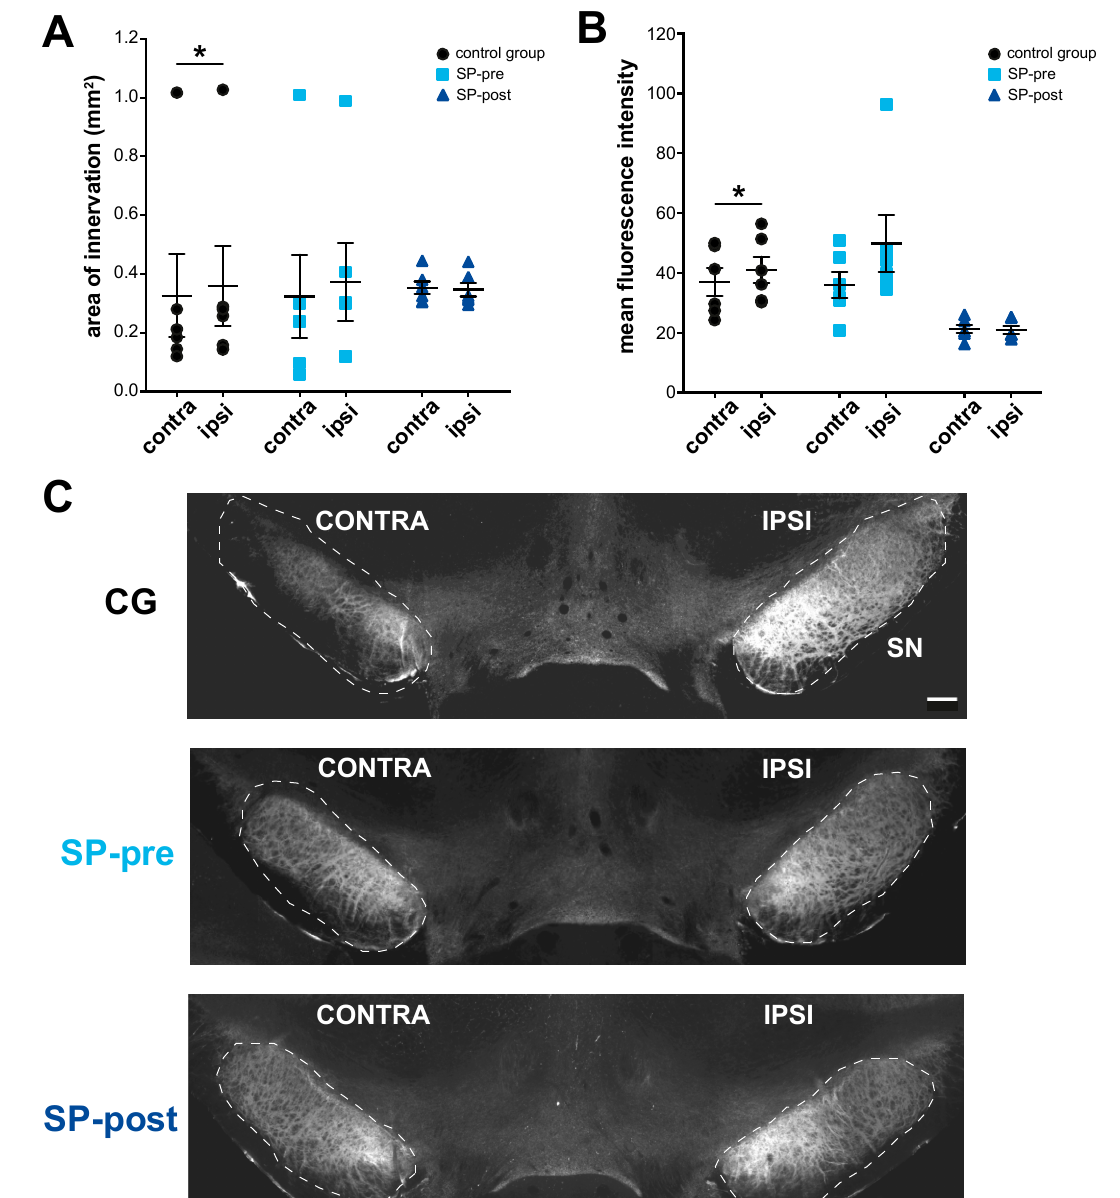
Figure 5. Substance P prevents ipsilesional hypertrophy of endogenous SPergic midbrain innervation after stroke. Comparisons of the area ( A ) and mean fluorescence intensity ( B ) of SP-immunoreactivity between hemispheres indicate an ipsilesional hypertrophy only in control animals. ( C ) Representative microscopy image (10 × magnification) of SP-immunoreactivity in the ventral midbrain 15 days after stroke. Scale bar: 100 µ m. Data presented with mean ± SEM, * p < 0.05. Scale bar: 100 µ